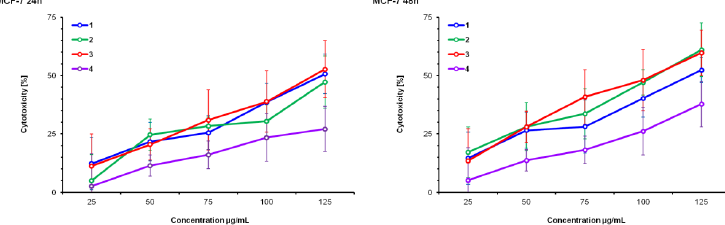
Figure 2. Cytotoxicity percentage determined by MTT test on MCF-7, after 24 h and 48 h exposures to V. vinifera extracts in a concentration ranging from 25 μg/mL to 125 μg/mL. (1) Dry extract — DE; (2) subcritical water extract — SWE; (3) resveratrol — R; (4) maltodextrin — M. Table 1. IC 50 values obtained by MTT test, after 24 h/48 h treatments of HeLa, MCF-7 and MRC-5 cells with dry extract, subcritical water extract, resveratrol and